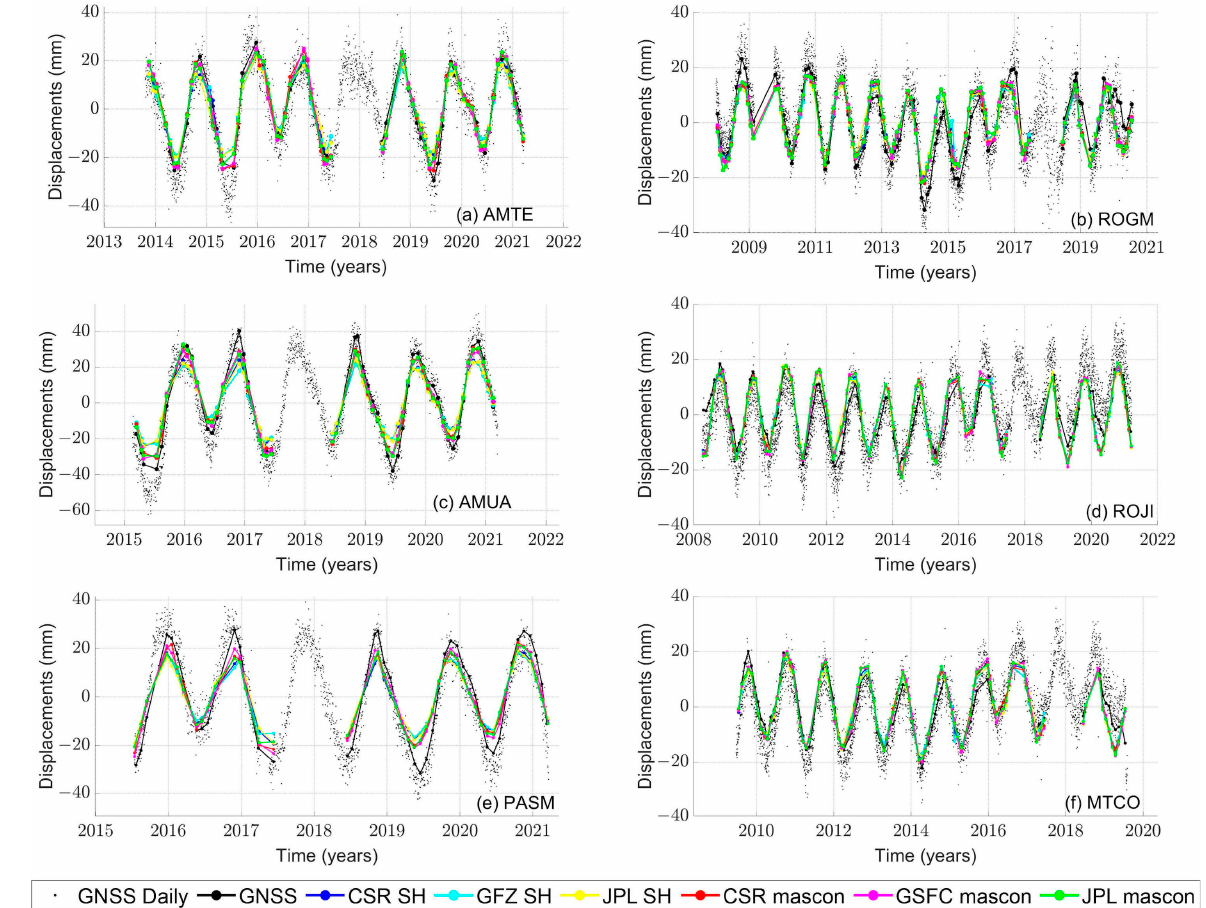
Figure 1. Time series of the vertical displacements at the six selected GNSS stations ( a ) AMTE, ( b ) ROGM, ( c ) AMUA, ( d ) ROJI, ( e ) PASM, and ( f ) MTCO.